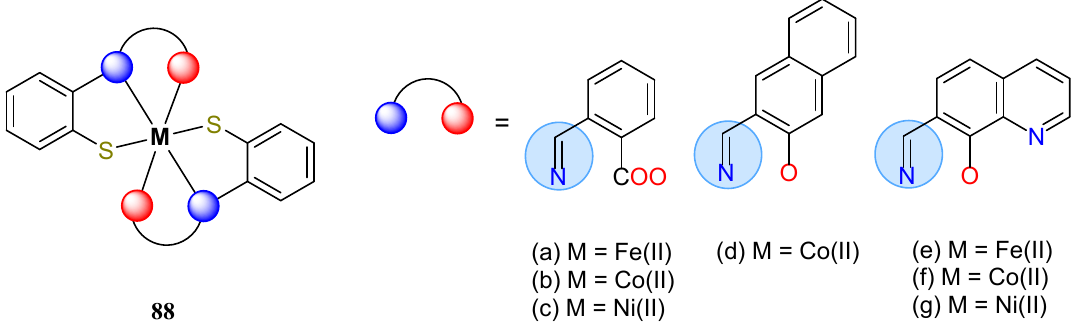
Figure 45. Fe(II), Co(II), and Ni(II) complexes with unsymmetrical tridentate Schiff base ligands prepared from 2 ‐ aminothiophenol with aldehydes. prepared from 2-aminothiophenol with aldehydes.